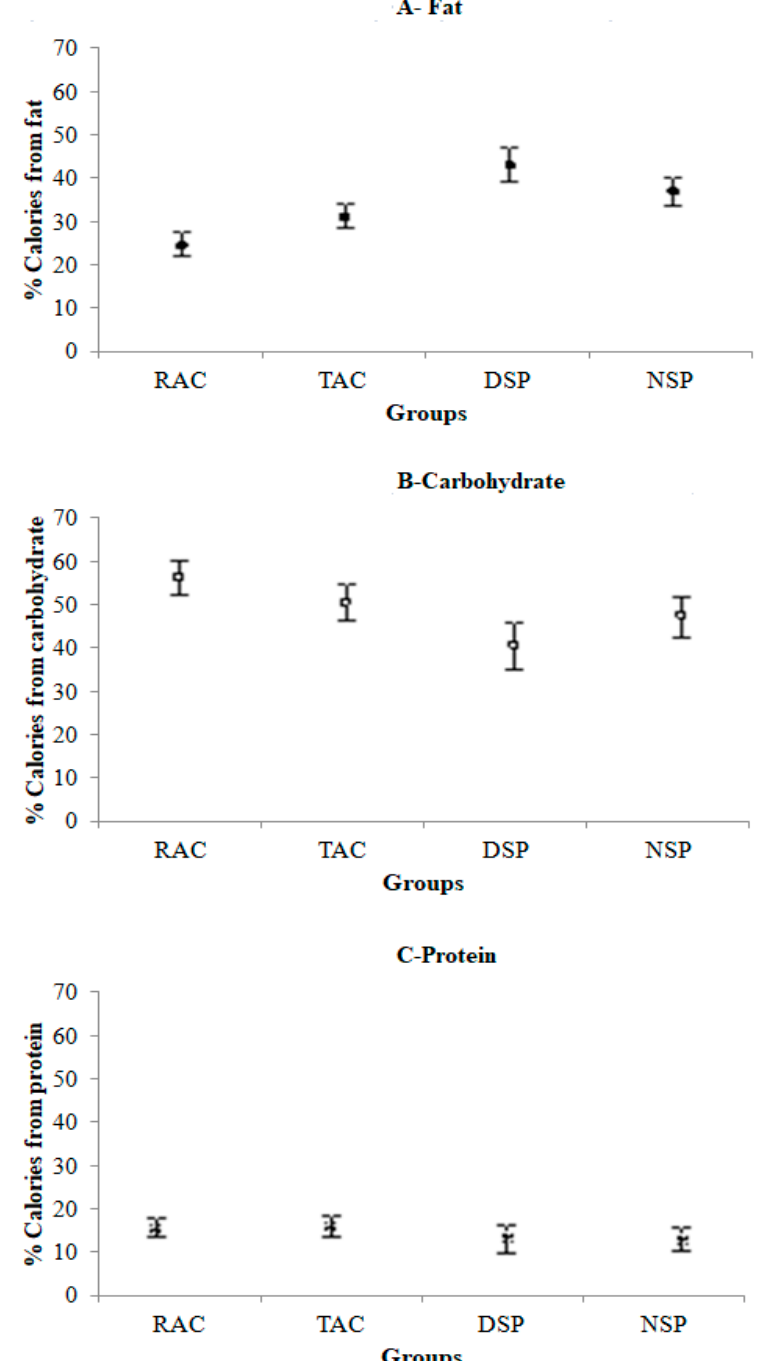
Figure 3. Calories derived from each macronutrient, according to group and adjusted for age. ( A ) Fat (GLM: F(3, 61) = 23.12, p < 0.001); ( B ) Carbohydrate (GLM: F(3, 61) = 8.35, p < 0.001); ( C ) Protein (GLM: F (3, 61) = 1.50, p = 0.225). RAC, n = 22; TAC, n = 19; DSP, n = 11; NSP, n = 14. Rural = RAC, town = TAC, city-day workers = DSP and city-night workers =